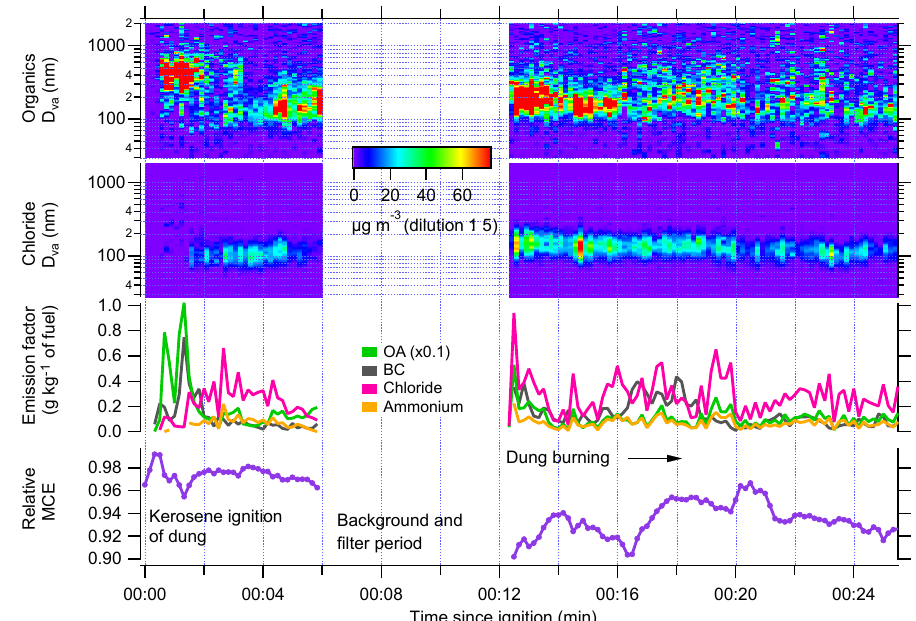
Figure 4. Time series of the modified combustion efficiency (bottom panel), aerosol emission factors, and chloride and organic mass size distributions (top panels) for the dung-burning emissions from a one-pot traditional mud stove. The 2-D time distributions are colored by the size-resolved dilute concentration as indicated by the color